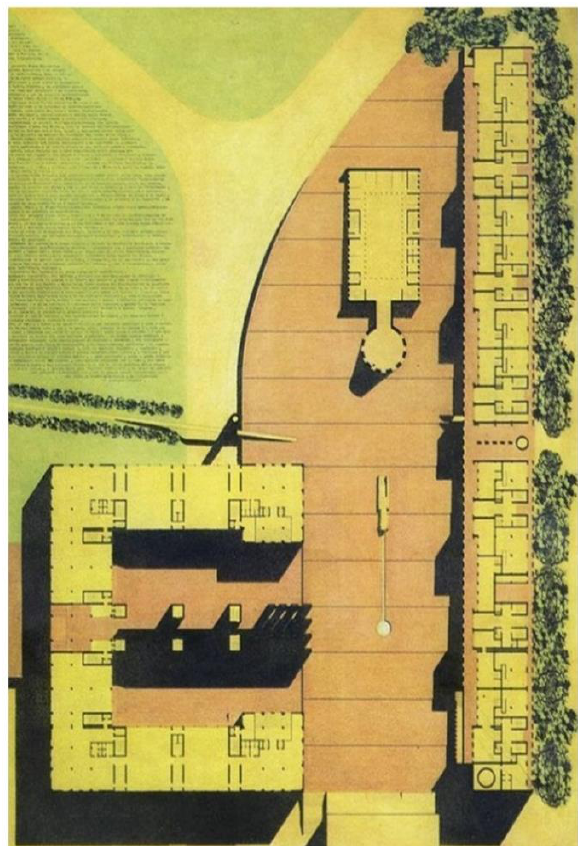
Figure 6 – Some frames of the recordings with Eye-Tracker in the current square. Circled in blue where the gaze rests, and in red the gaze rapid movement.